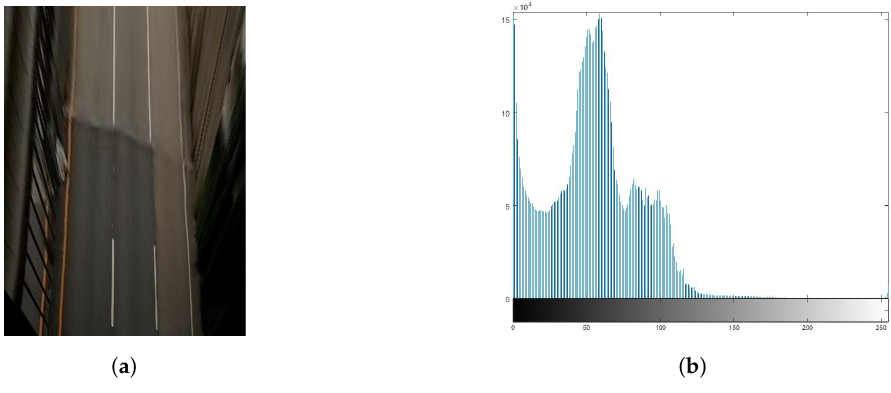
Figure 4. Histogram for region of interest: ( a ) region of interest image; ( b )